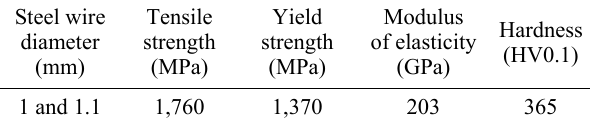
Table 2 Mechanical properties of